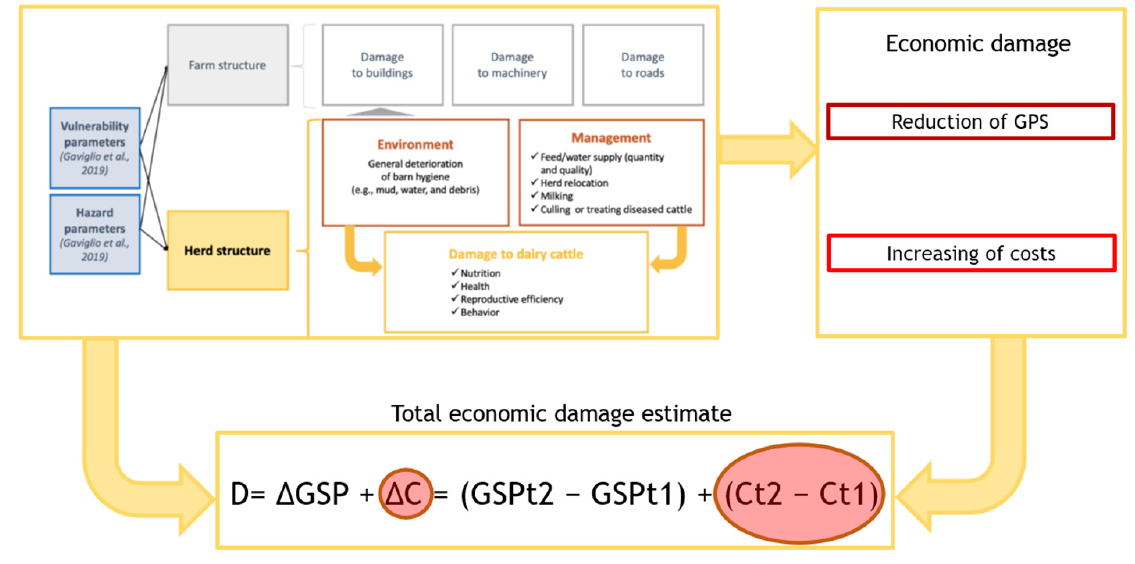
Figure 1. The methodological approach (elaboration from [22]).